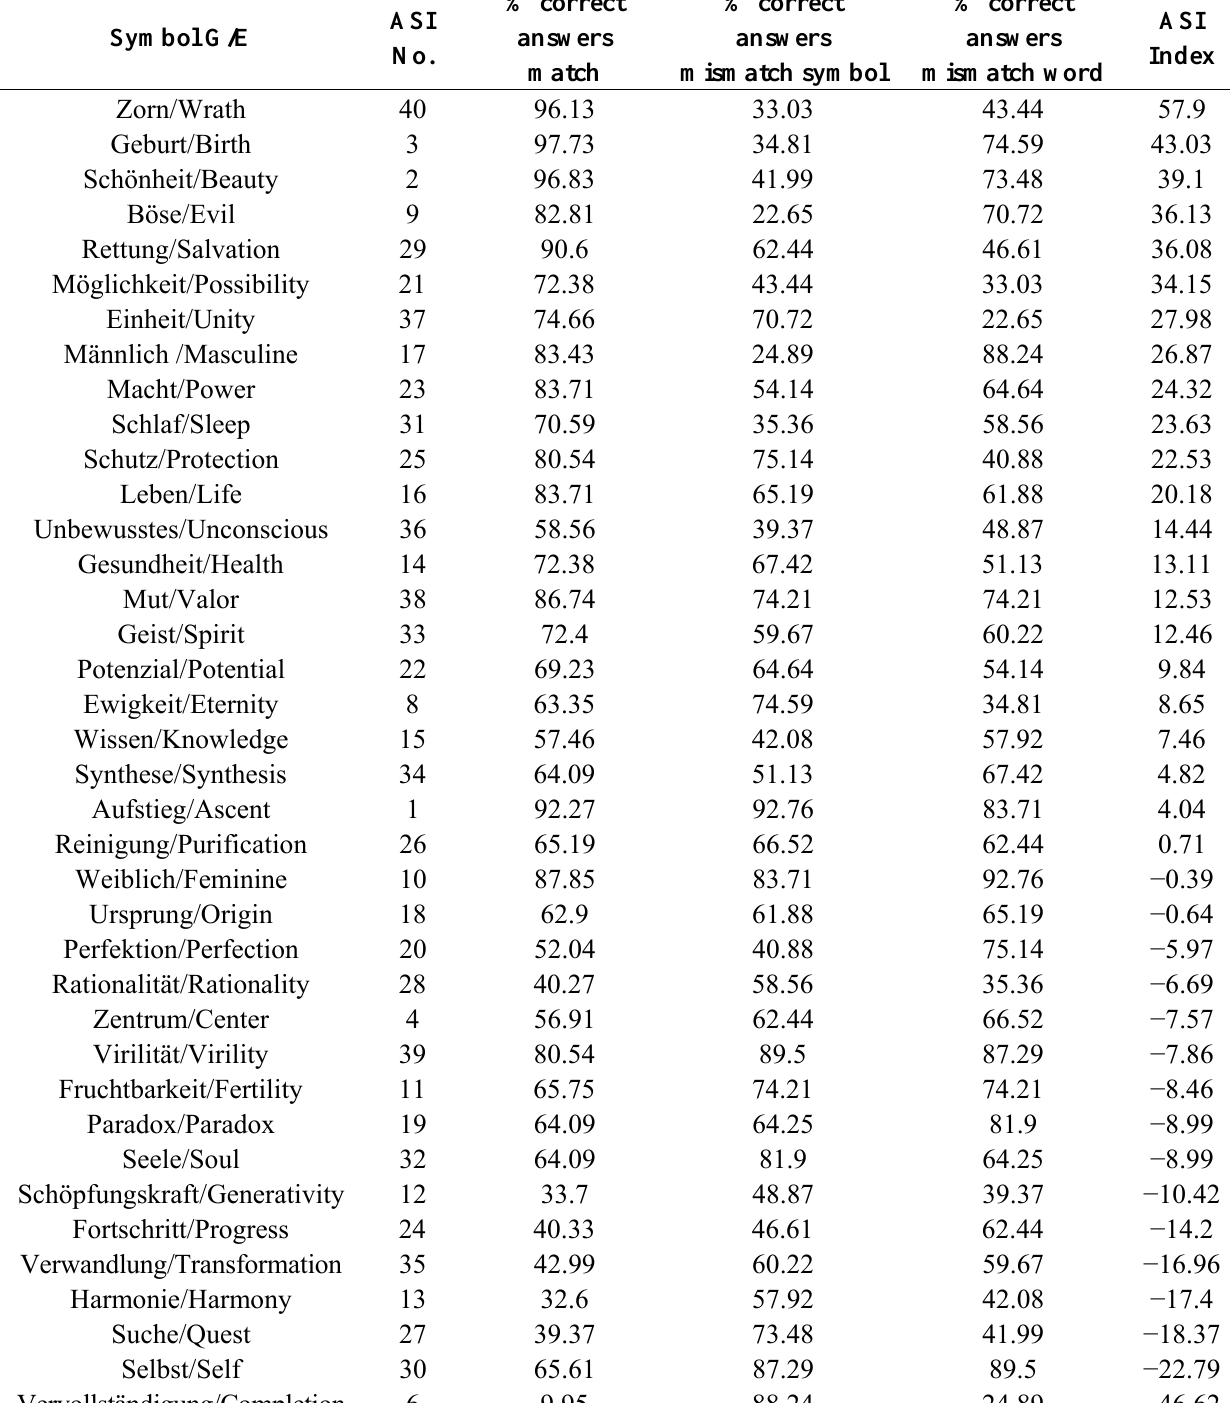
Table 2. Archetypal Symbol Inventory (ASI) Summary of item analysis: rank-ordered